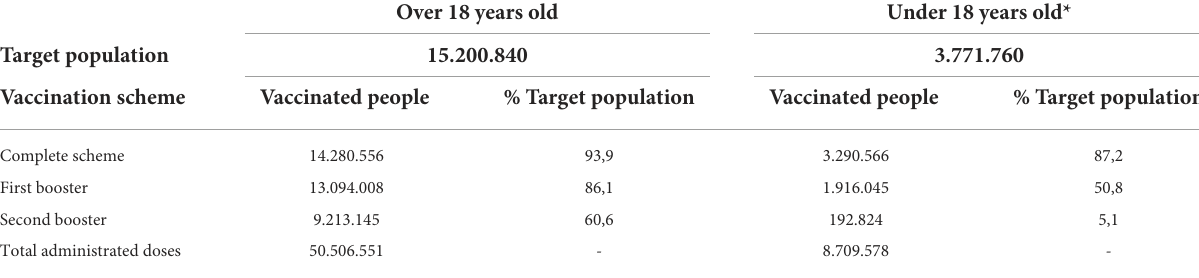
TABLE 1 SARS-CoV-2 vaccination campaign, in Chile until 01 July 2022.